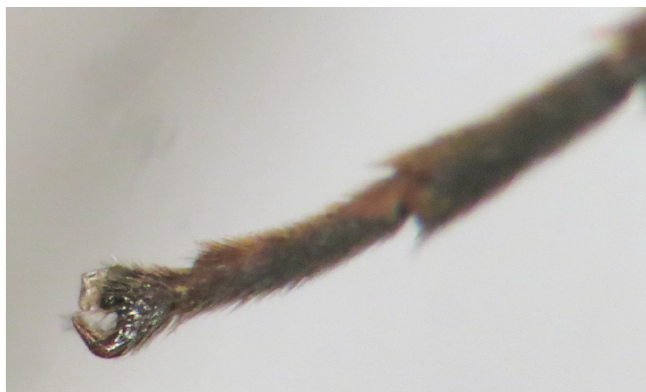
Figure 14. Heinrichiella obscura comb. n., hind claw